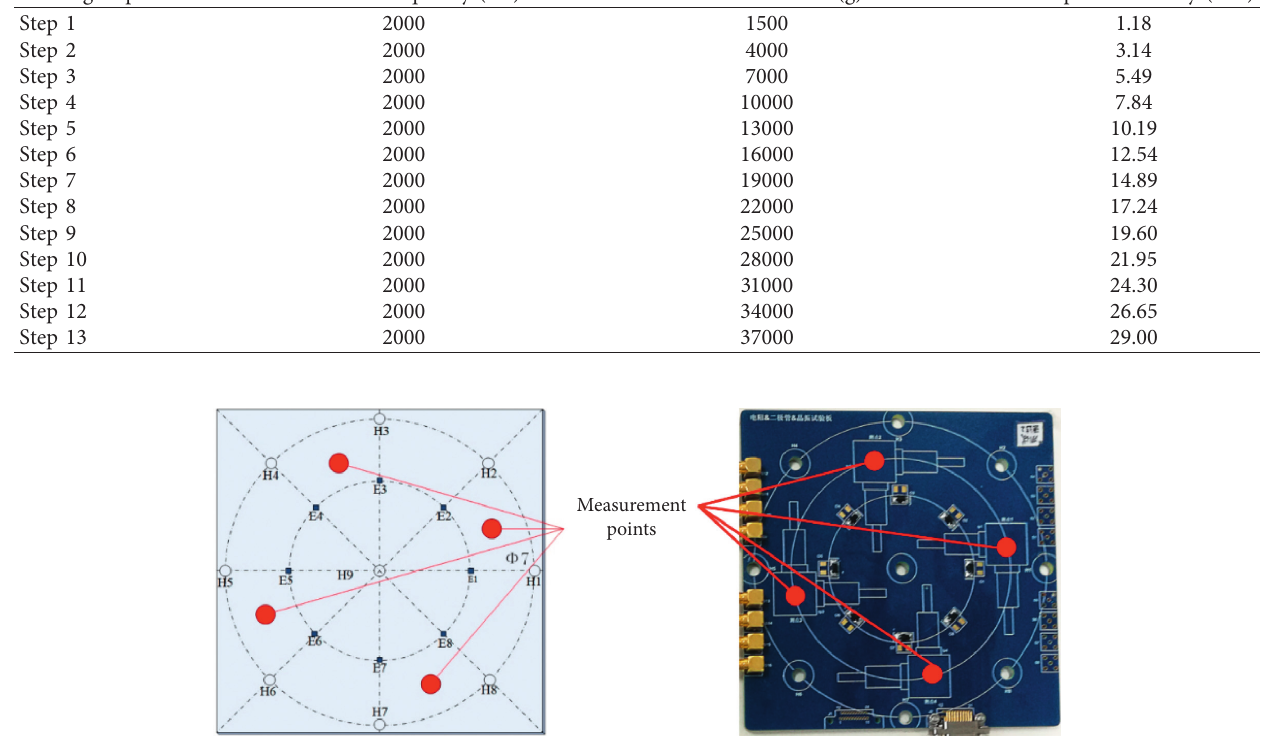
Figure 9: Distribution of measurement points. Table 3: The mass property of the acceleration